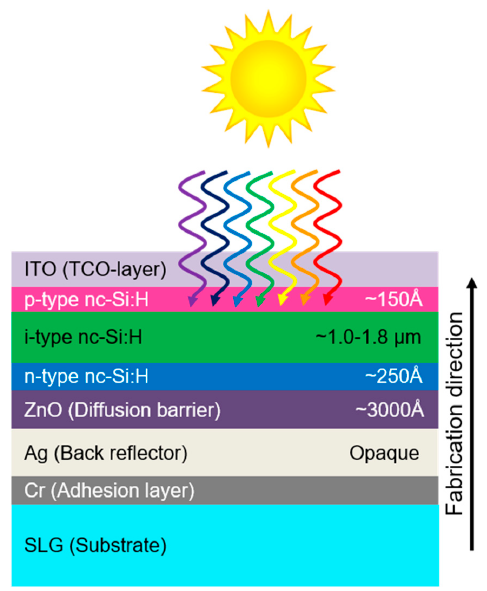
Figure 1. Schematic diagram of nc-Si:H absorber based solar cell in the n-i-p substrate